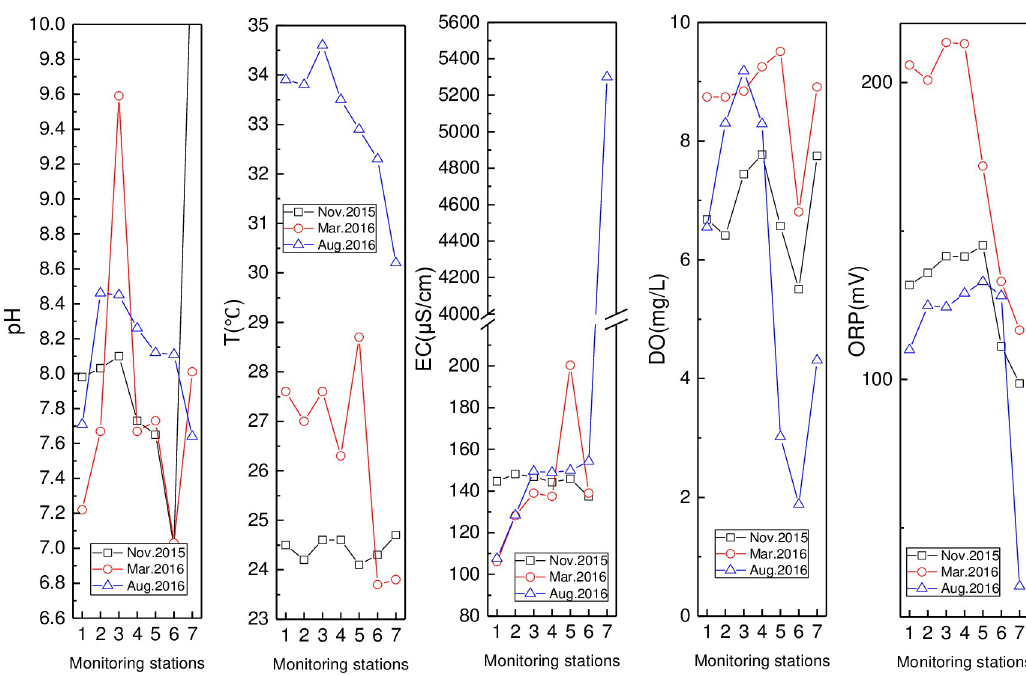
Fig 3. Variation of pH, T, EC, DO, and ORP in Wenjiao River (monitoring stations including HN15, HN14, HN11, HN10, HN09, HN08 and HN33 were represented by numbers from 1 to 7).